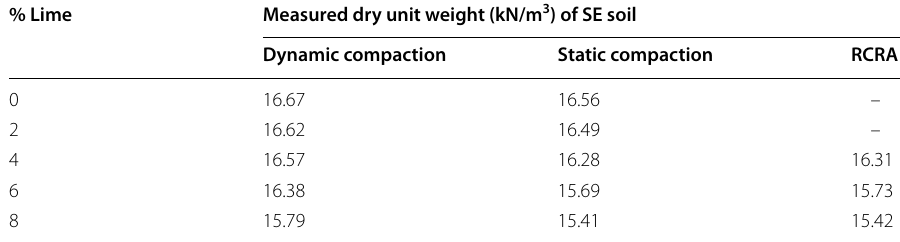
Table 8 Measured dry unit eight of soil SE treated by lime % Lime